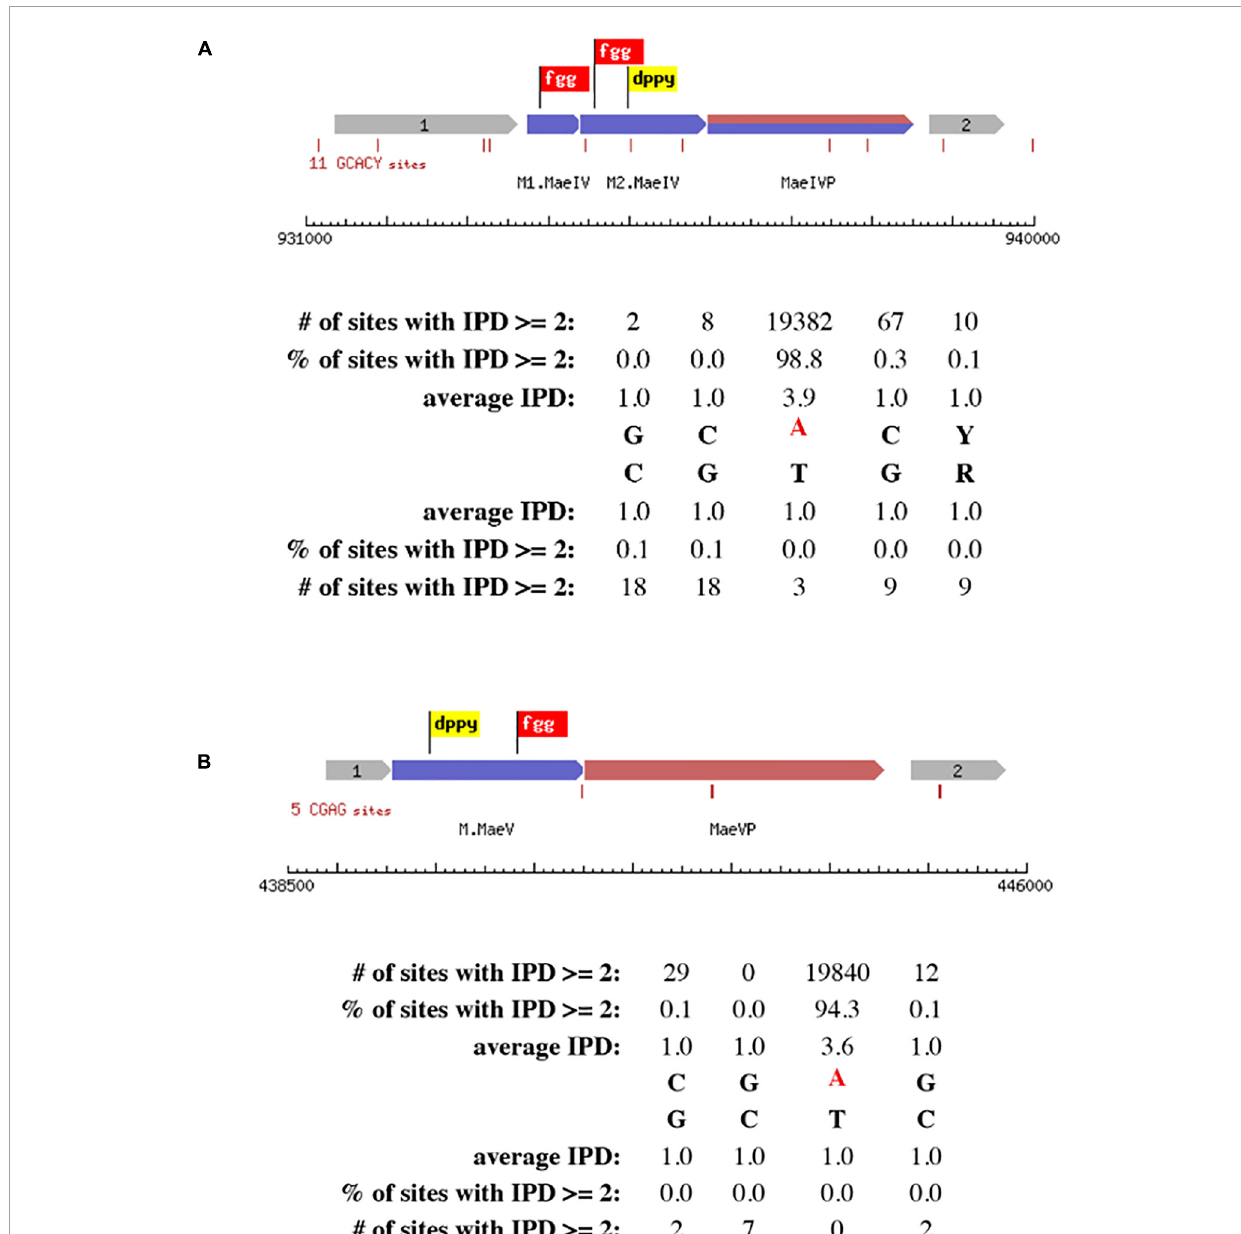
FIGURE3 Schematic presentation of RM systems assigned experimentally by cloning and SMRT motif and modification analysis. The correct motifs were verified by analyzing SMRT kinetic data using MotStat software (Vincze, unpublished) for M.MaeIV (A) and M.MaeV (B) . The flags represent the conserved motifs that are used to identify the methyltransferase